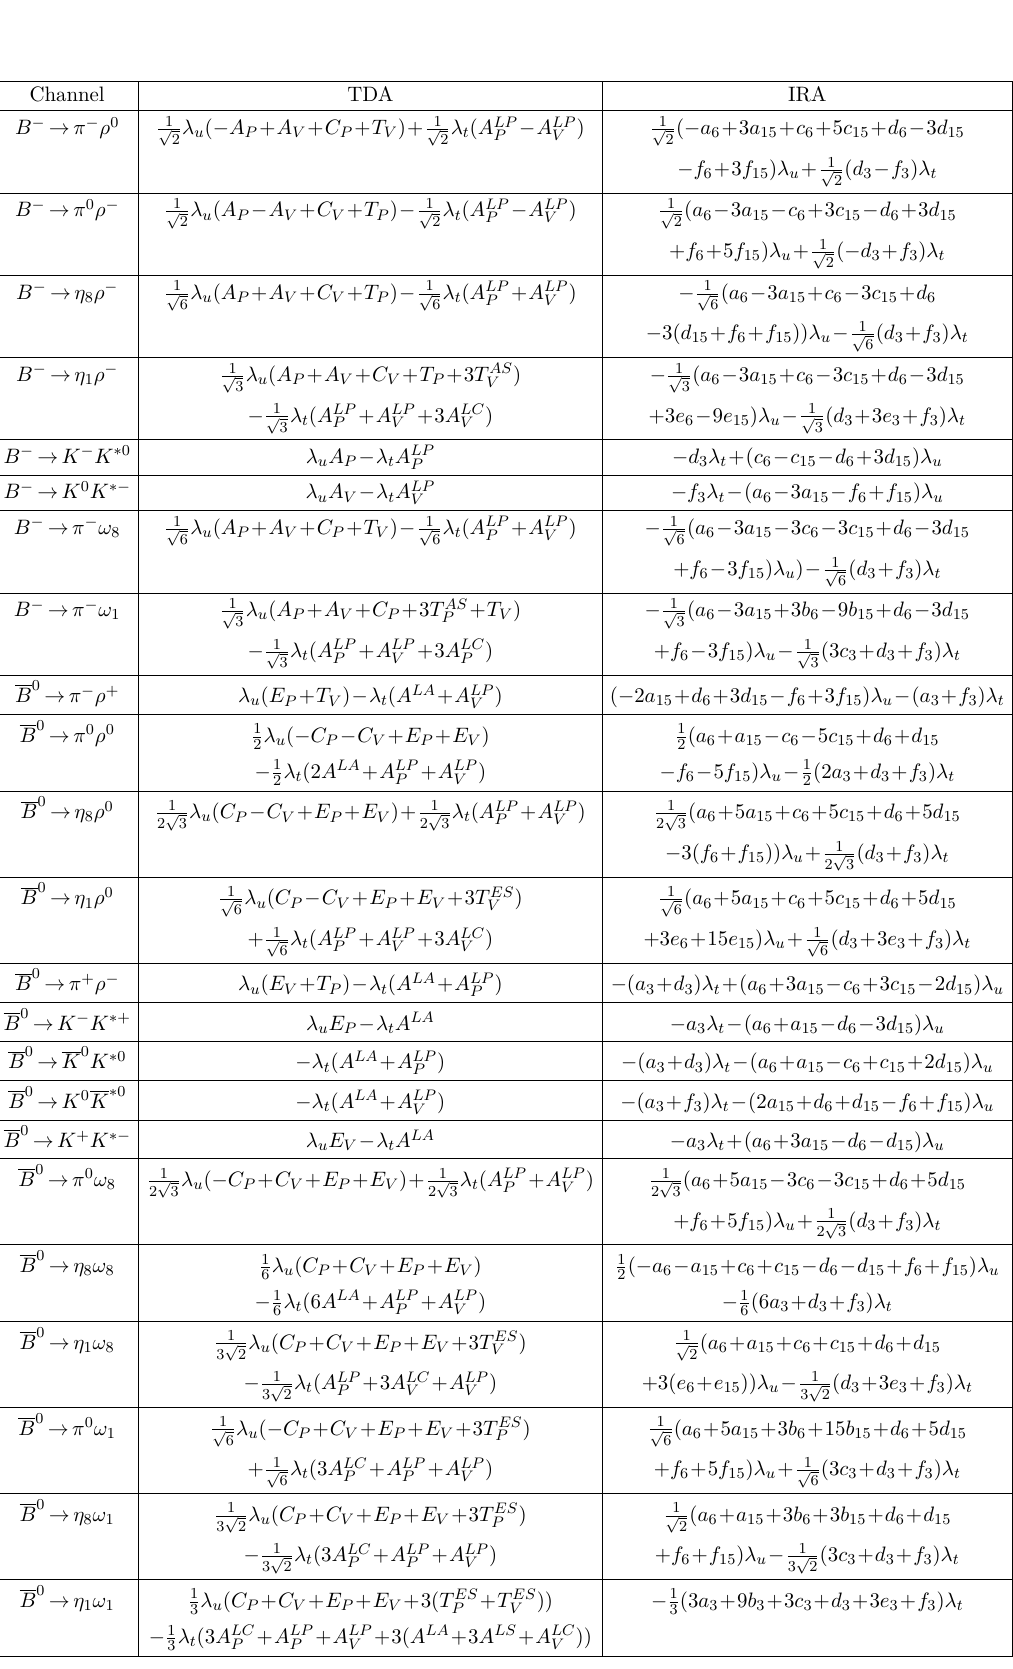
Table 8 . Decay amplitudes of the B u,d → PV decays induced by the b → d